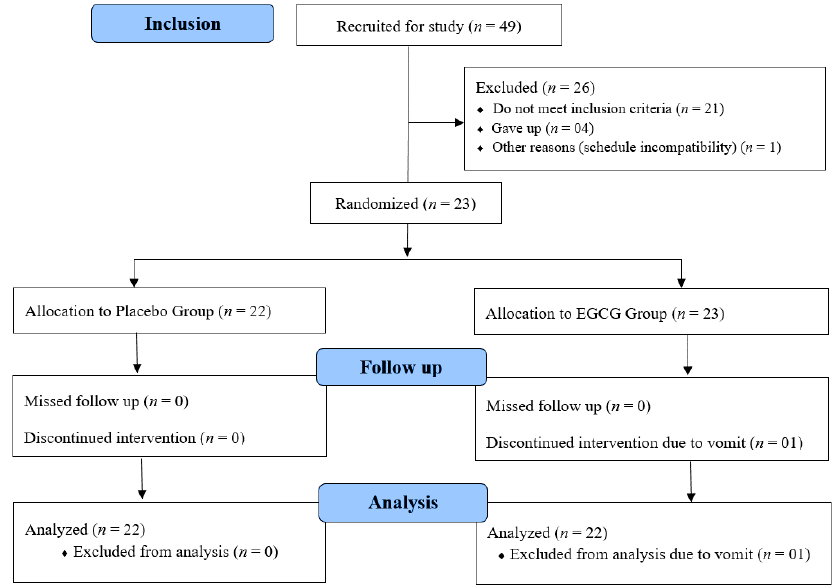
Figure 2. Study flowchart.